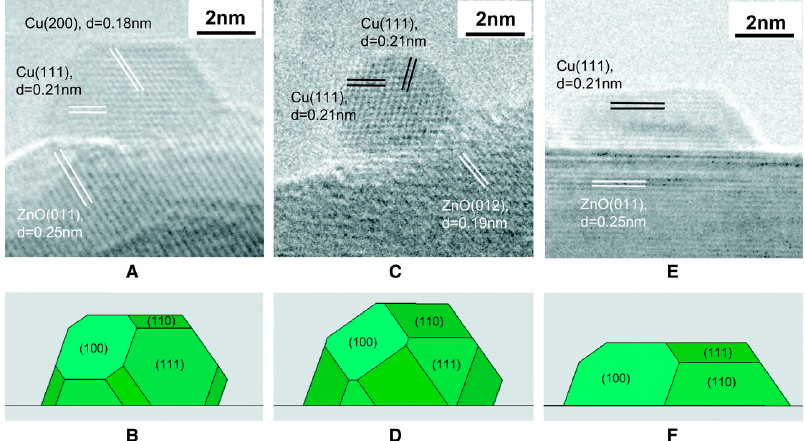
Figure 6. E-TEM analysis of catalyst reconstruction under reactive conditions: ( A , C , E ) Micrographs of Cu nanoparticles deposited on ZnO captured with in situ TEM analysis, ( B , D , F ) together with their corresponding Wulff constructions illustrating the reactive gas phase induced shape transformations of the Cu nanoparticles. Conditions of acquisition: T = 493 K, ( A ) P H2 = 150 Pa; ( C ) P tot = 150 Pa with P H /P O = 3.1; ( E ), P tot = 500 Pa with P H /P O = 19.1. Reprinted from [173]. Copyright 2002, AAAS.